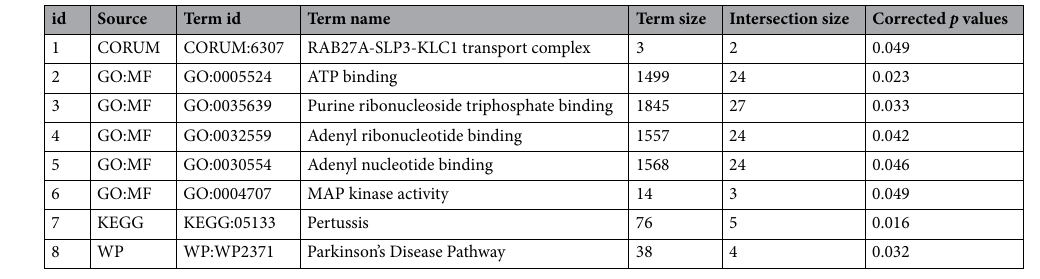
Table 1. Significant biological and functional enrichment for pleiotropic genes associated with T1D and T2D. Corum, comprehensive resource of mammalian protein complexes; MF, molecular function; KEGG, Kyoto Encyclopedia of Genes and Genomes; WP,